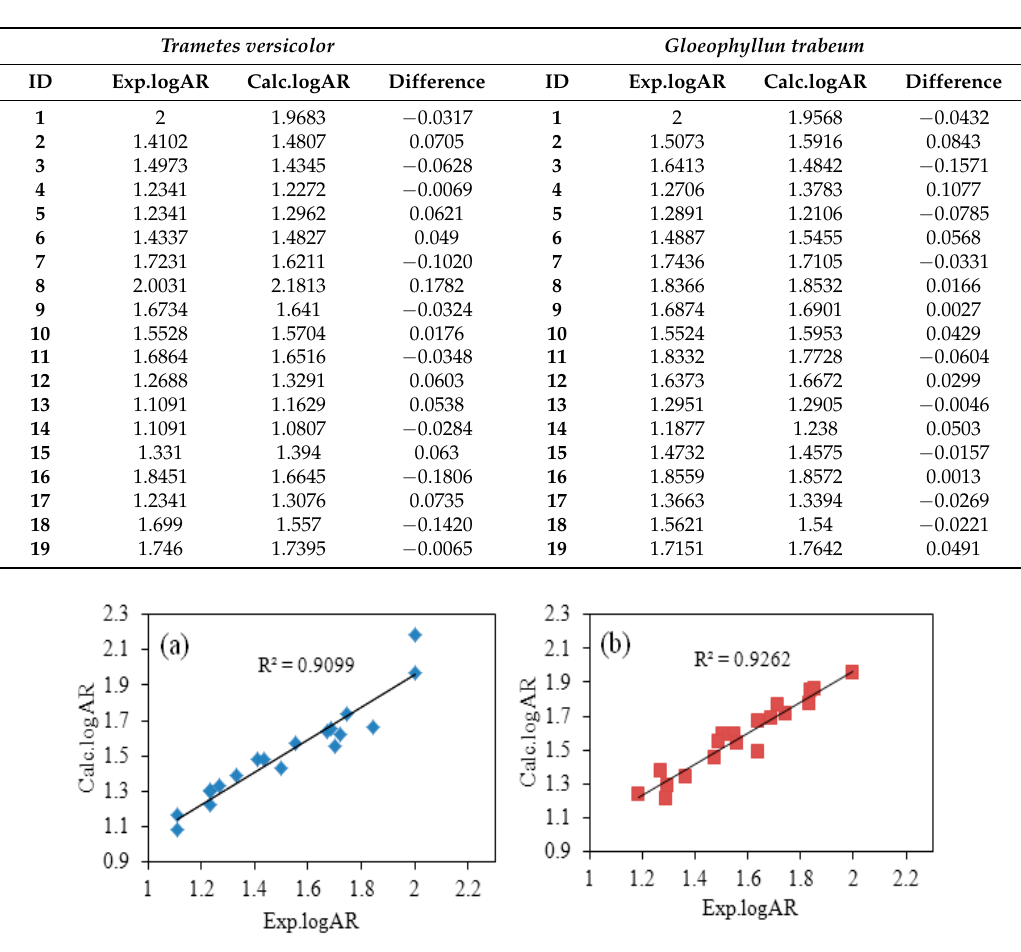
Figure 2. Experimental logAR versus predicted logAR according to the best QSAQ model (( a ) is for Trametes versicolor ; ( b ) is for Gloeophyllun trabeum